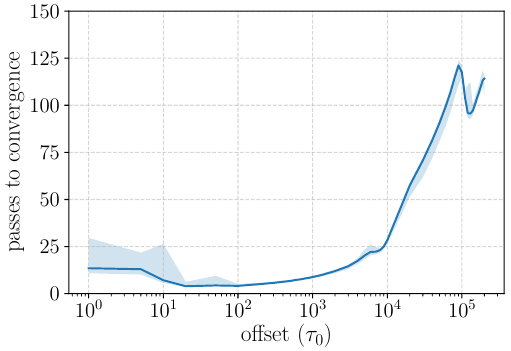
Figure 17 . Number of passes needed for convergence as a function of the o(cid:11)set, for an event sample with 10 5 events and a chunk size of 10 4 . The calculations were done for 100 di(cid:11)erent random seeds, the blue lines show the mean of these and the shaded regions cover the upper and lower standard deviations. Separate upper and lower standard deviations are used to show how the actual variances in the number of required passes are skewed with respect to the